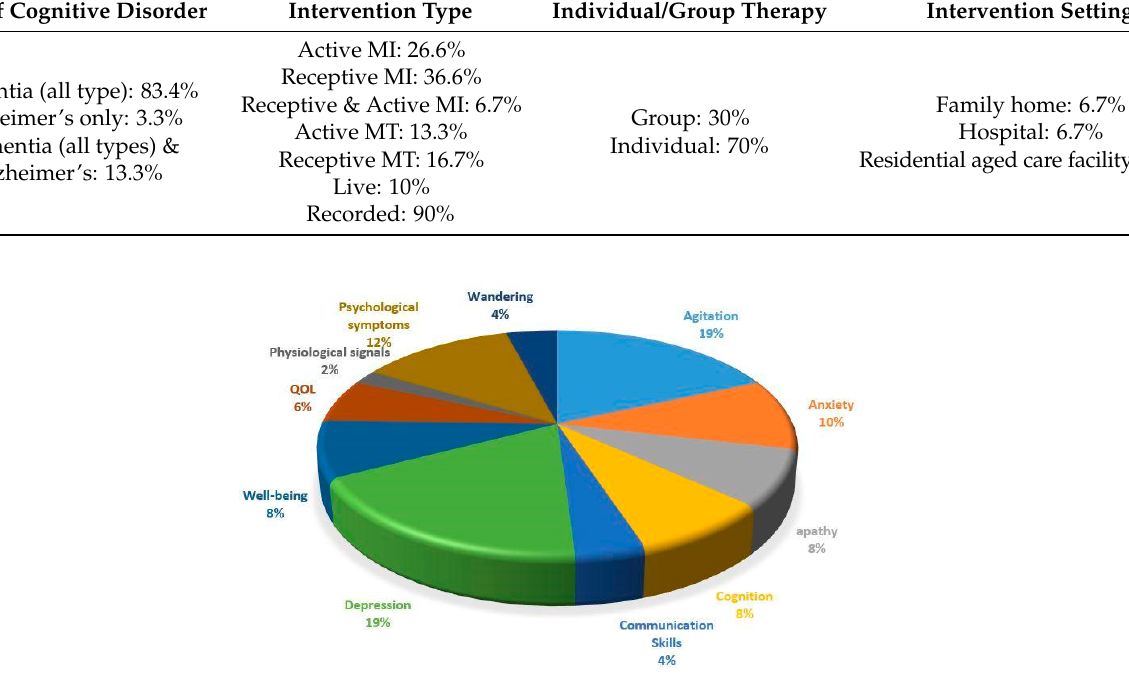
Figure 4. Percentage of music treatment research in each area of dementia.